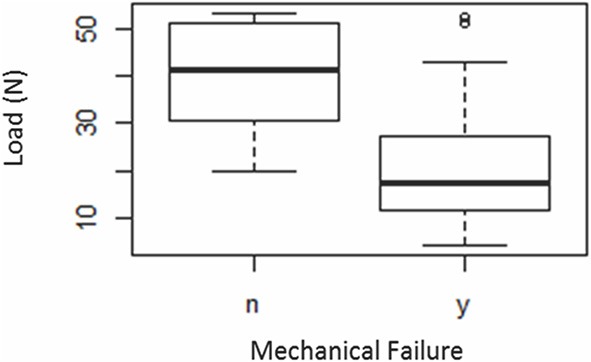
Box-plot representing the load at maximum displacement and load at mechanical failure (n = 125): “y”—failed, “n”—did not fail. The bold horizontal line within the boxes indicate the median load values. The circular symbols indicate outlying data points.